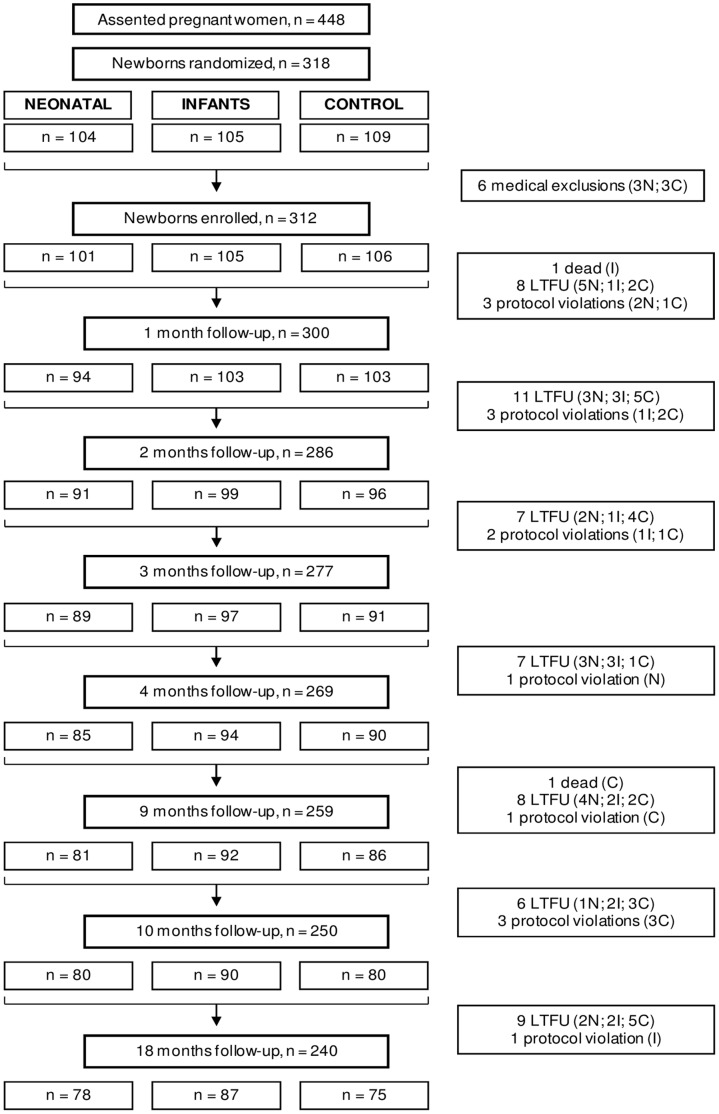
Flow diagram of the study [31].Flow diagram indicating number of women who assented and children enrolled into the study, randomized to neonatal or infant PCV7 or control groups and number excluded or lost to follow-up in the course of the study. PCV = 7-valent pneumococcal conjugate vaccine; N = Neonatal group; I = Infant group; C = control group; LTFU = lost to follow-up (includes not located, withdrew consent, migration). Numbers (n) are total excluding LTFU and protocol violations.